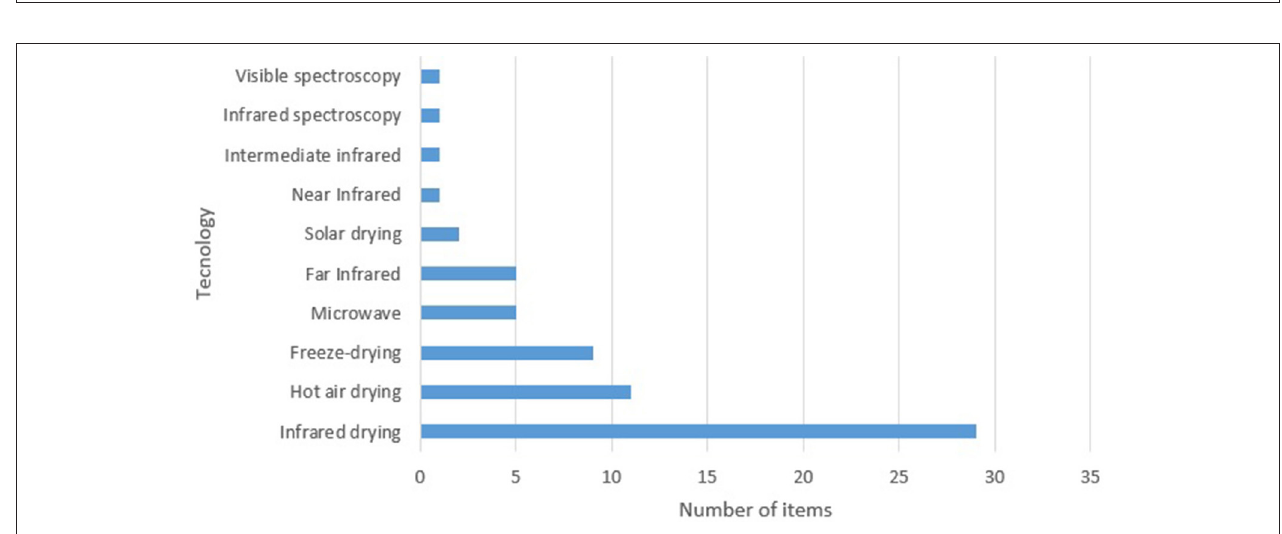
FIGURE 1 | Stages of paper creation. Source: the authors.